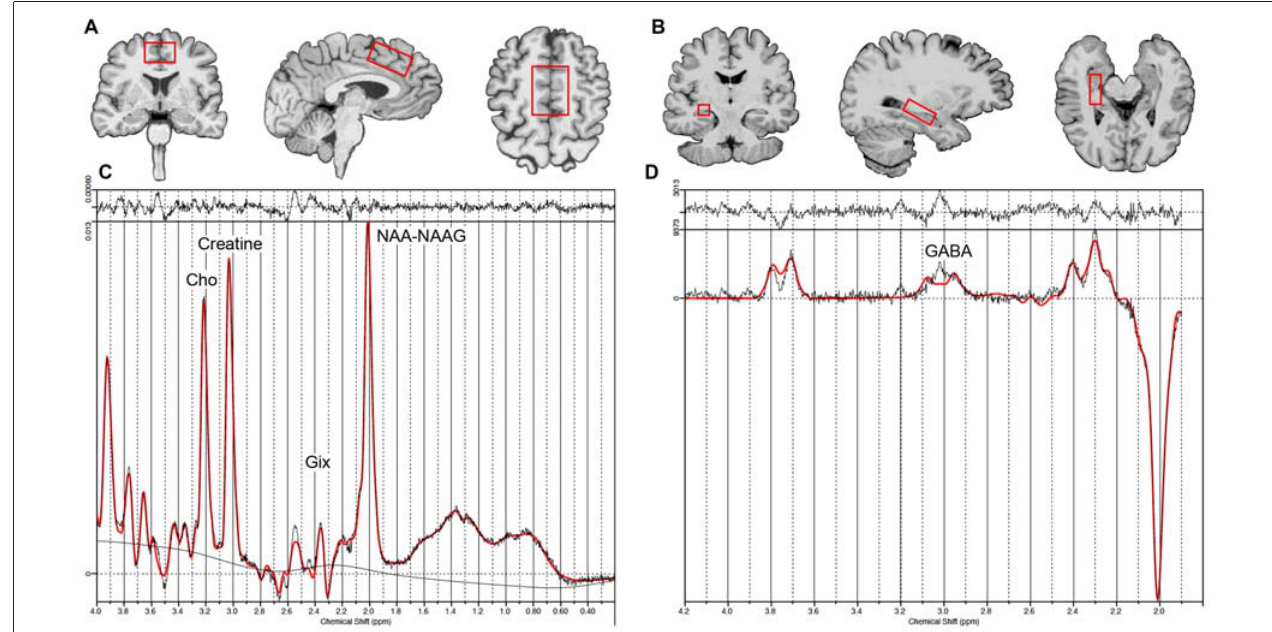
FIGURE 2 | Example voxel placement for the dorsal ACC (A) , right hippocampus ( B , voxel location for the left hippocampus is similar to the right) and example LC model processing output for the non-edited (C) and edited difference spectra (D) . Creatine, Phosphocreatine + Creatine; Glx, glutamate+ glutamine; Cho, glycerophosphocholine + phosphocholine; NAA-NAAG, N-acetyl aspartate + N-acetylaspartyl-glutamate; GABA, γ -Aminobutyric acid.